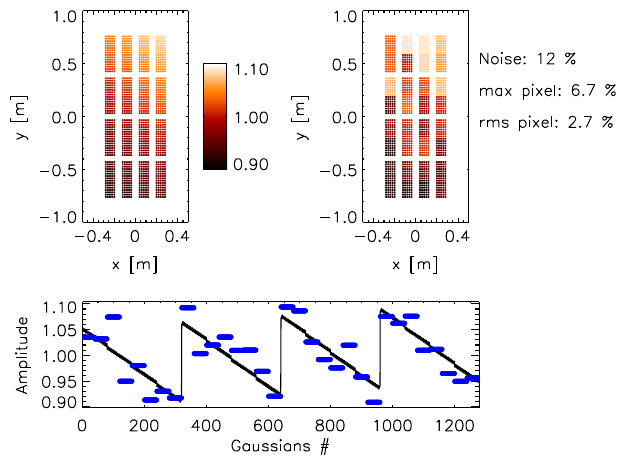
FIG. 7. Phantom 8 (top left) and its tomographic reconstruc- tion (top right) using the 32 pixel configuration with noisy data. The rms of the ratio noise/signal is 12%.